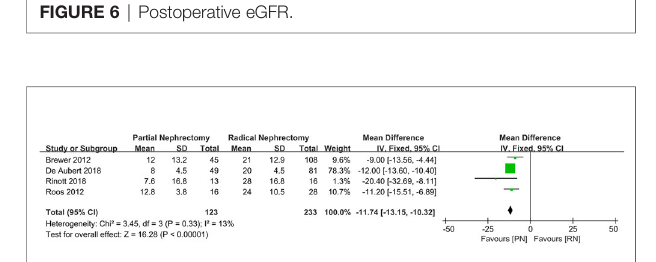
FIGURE 7 | Decline in